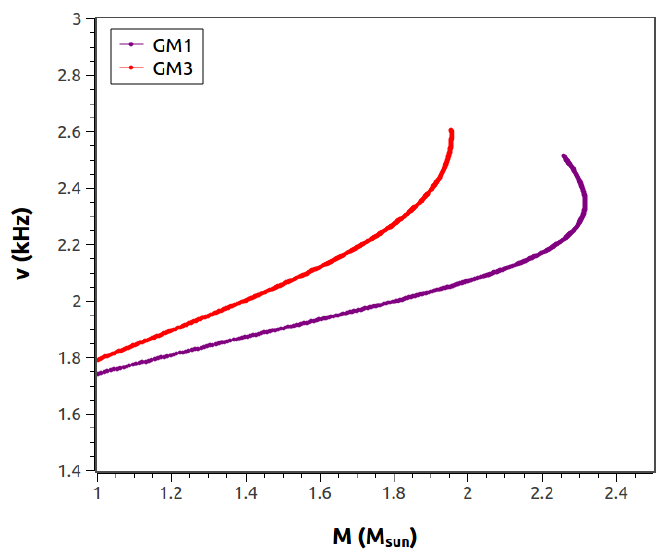
Figure 3. The f -mode frequencies, ν , as a function of total mass. M , for the parameter sets GM1 and